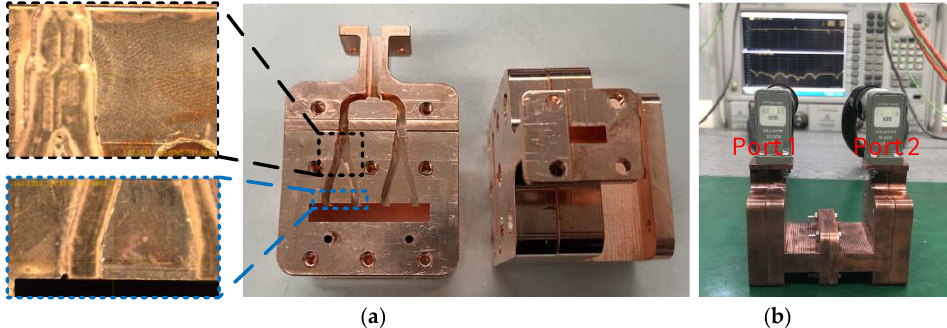
Figure 6. ( a ) Manufacture and partially enlarged view of the Y-type power divider and rectangular aperture. ( b ) Measurement of the mode converter.